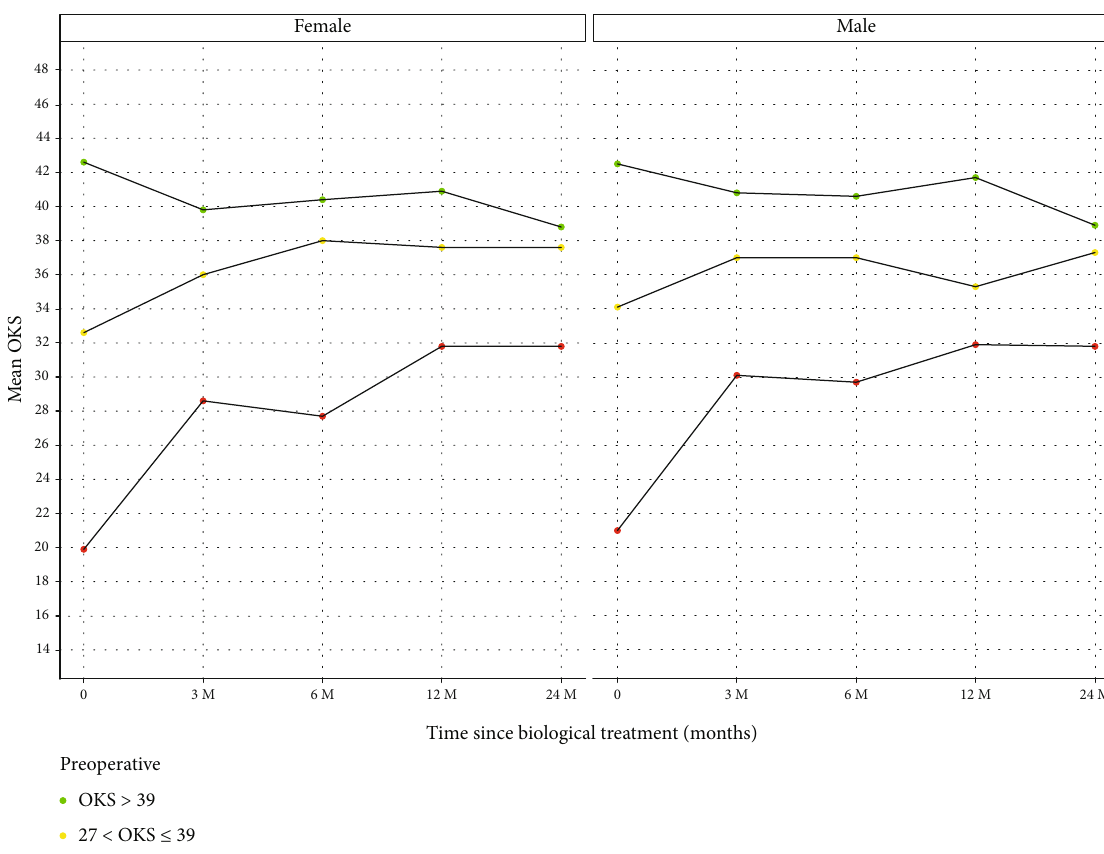
Figure 5: Patients grouped by OKS at baseline with follow-up OKS at 3, 6, 12, and 24 months. x -axis: Time points in relation to treatment: baseline prior to treatment (0), 3, 6, 12, and 24 months posttreatment. y -axis: OKS mean for each group. Green (d1): baseline OKS > 39 . Yellow (d2): baseline > 27OKS ≤ 39 . Red (d3): baseline OKS ≤ 27